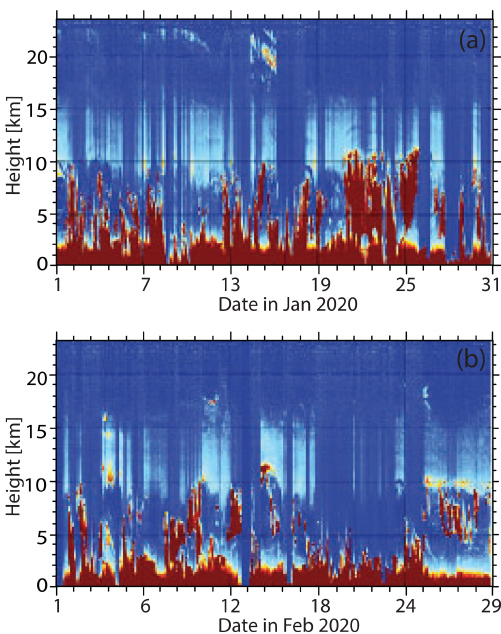
Figure 10. UTLS aerosol layer (light blue layer, 8–16km) over the North Pole region in (a) January 2020 and (b) February 2020. A few PSCs are visible above 18km in January and between 15 and 20km in February. Cirrus (in red) formed in the lower part of the UTLS smoke layer and produced long virga (in red). Below 3km, Arctic haze prevailed. The range-corrected 532nm backscatter sig- nal observed with a high spectral resolution lidar aboard Polarstern is shown (HSRL,